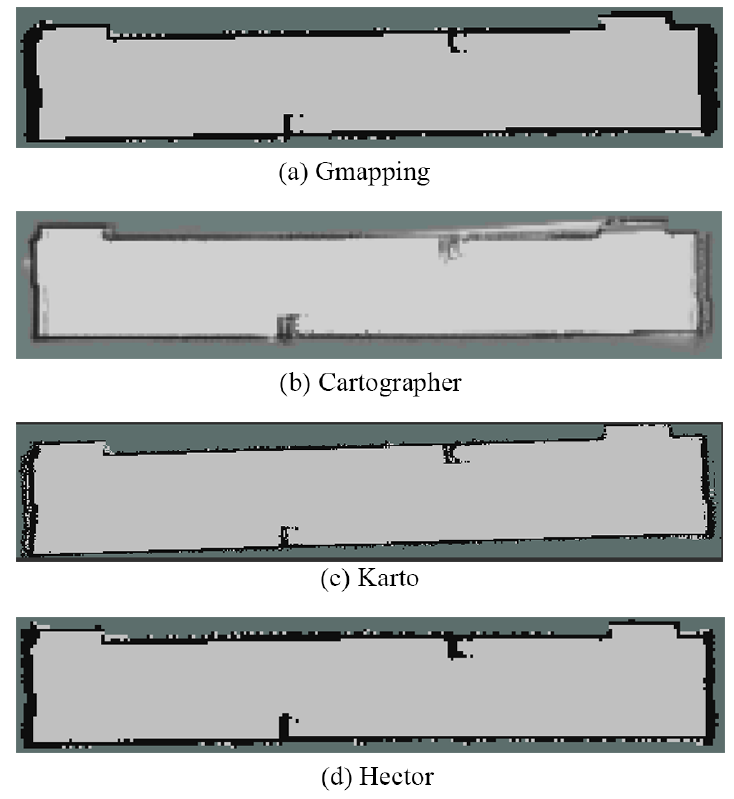
Figure 10. Grid map of simulated roadway based on laser SLAM.